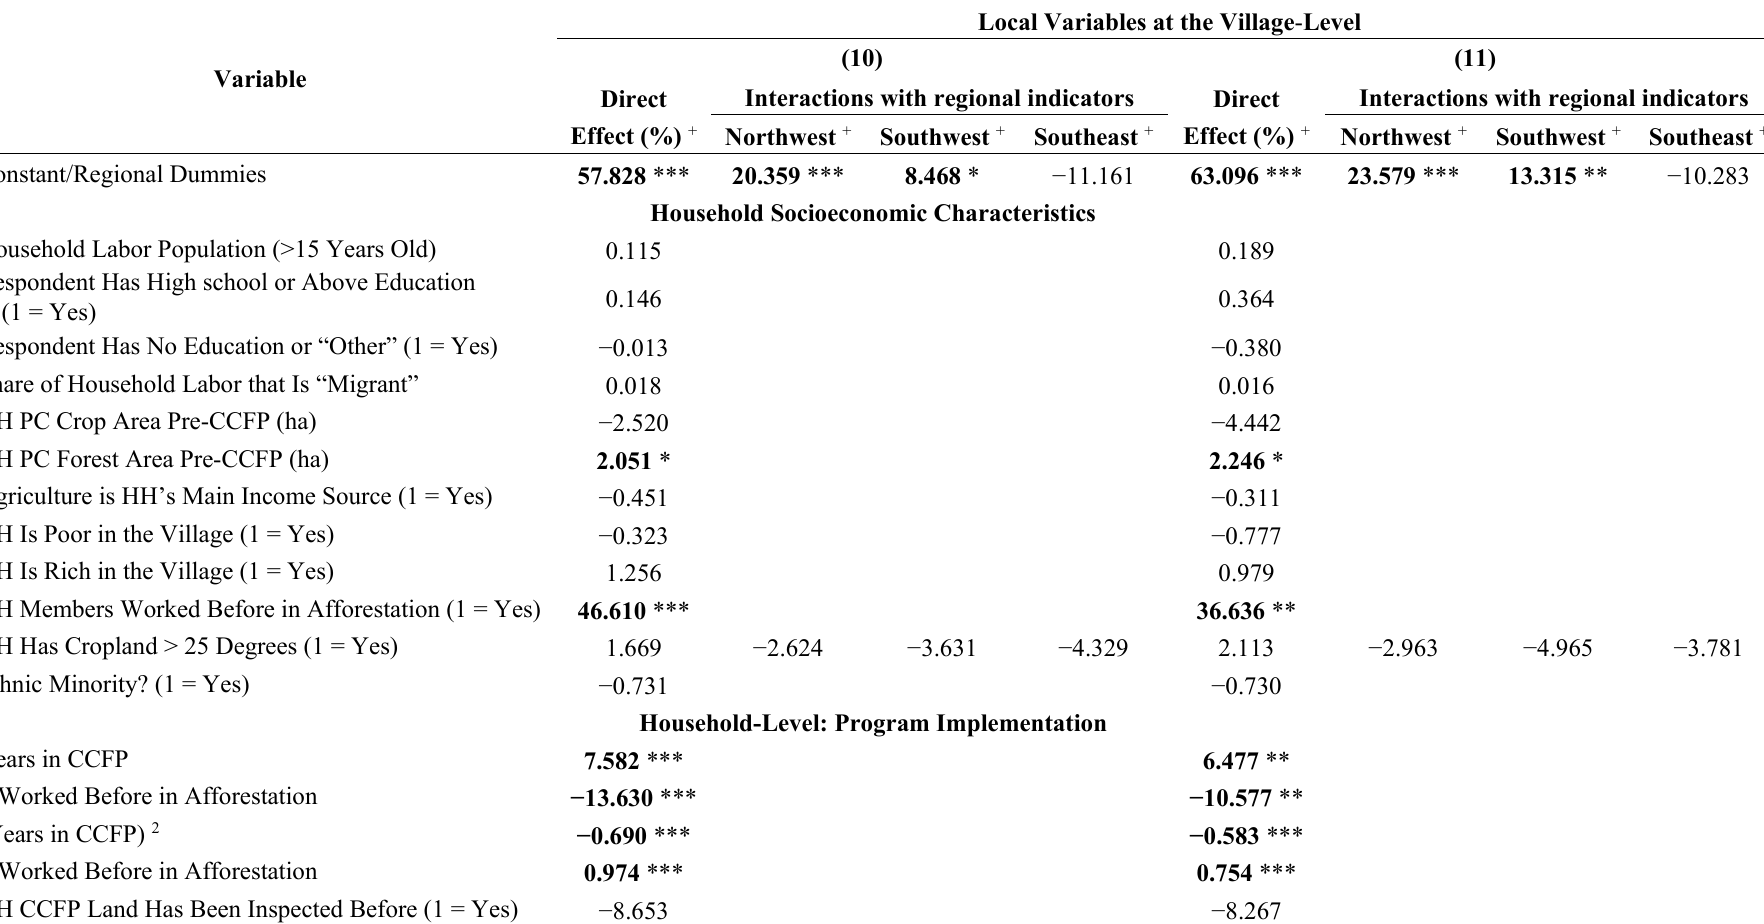
Table 6. Interval regression model of tree survivorship on household conversion of cropland to forests program (CCFP) enrolled land with regional